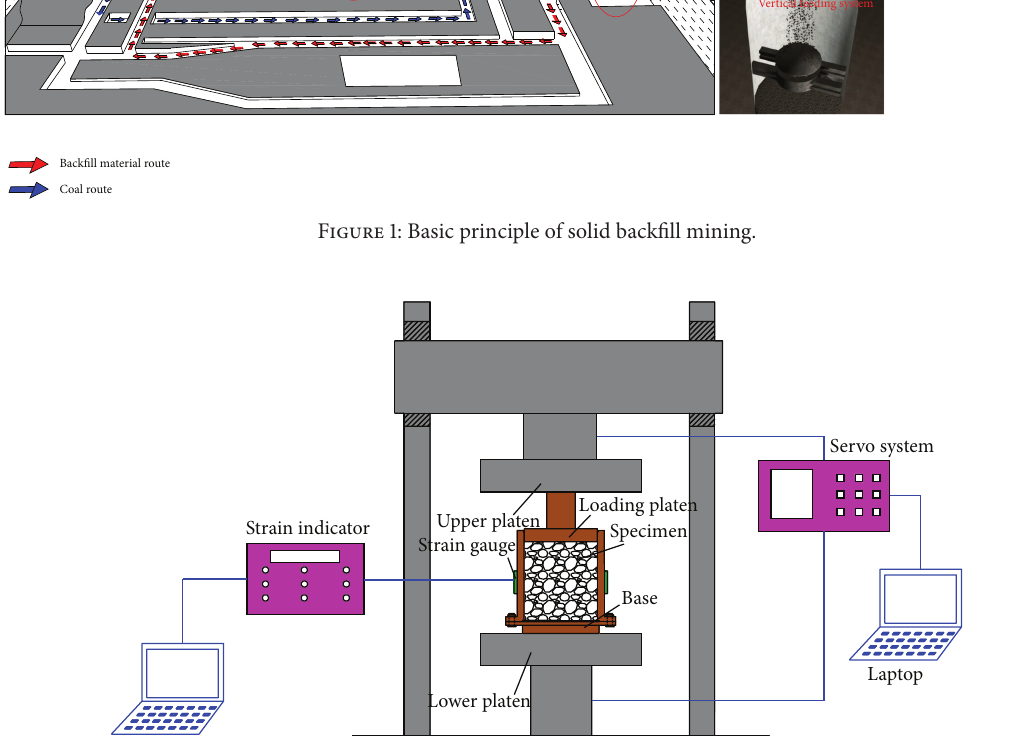
Figure 2: Schematic diagram of test